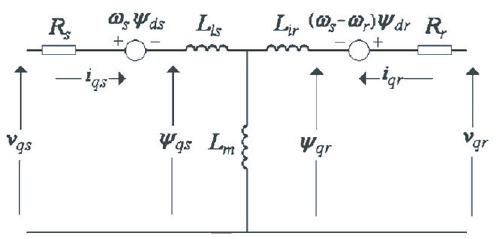
Figure 7. Equivalent circuit of the DFIG in the q